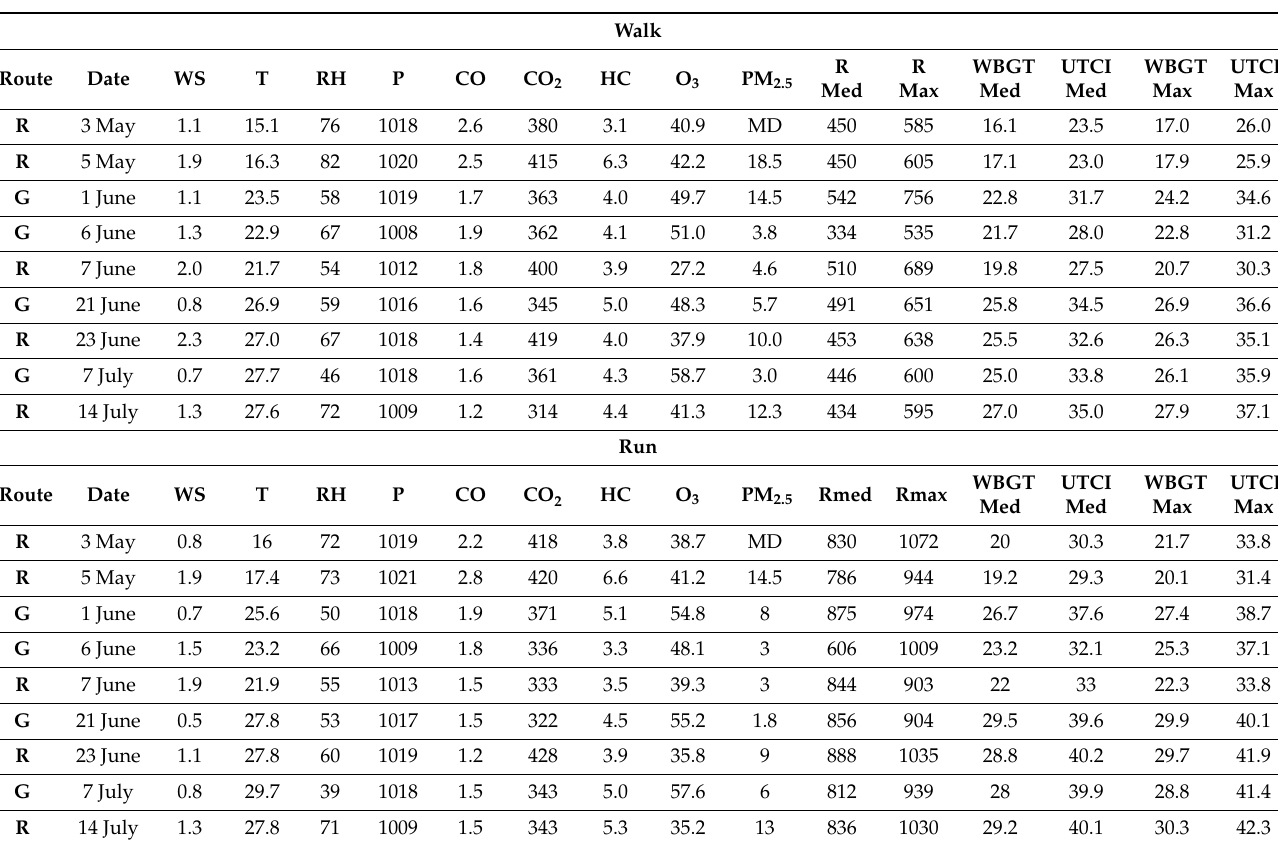
Figure 3. Typical examples of EKG monitored during walking ( A ) and running ( B ). The average values for each of the environmental and pollutant parameters were monitored and collected during the days of the field tests, and the parameters recorded for each subject when running and walking are shown in Table 2. Table 2. Mean values of environmental parameters collected by the nodes during the tests for each experimental session of green and red routes. Route: R = red, G = green; WS = wind speed (m/s); T = temperature ( ◦ C); RH = relative humidity (%); P = atmospheric pressure (hPa); CO = carbon monoxide (ppm); CO 2 = carbon dioxide (ppm); HC = hydrocarbons (ppm); O 3 = ozone (ppb); PM 2.5 = particulate matter (ug/m 3 ); Rmed = average solar radiation (W/m 2 ); Rmax = maximum solar radiation (W/m 2 ); WBGTmed = average wet bulb globe temperature ( ◦ C); WBGTmax = maximum wet bulb globe temperature ( ◦ C); UTCImed = average universal thermal climate index ( ◦ C); UTCImax = maximum universal thermal climate index ( ◦ C). MD: missing